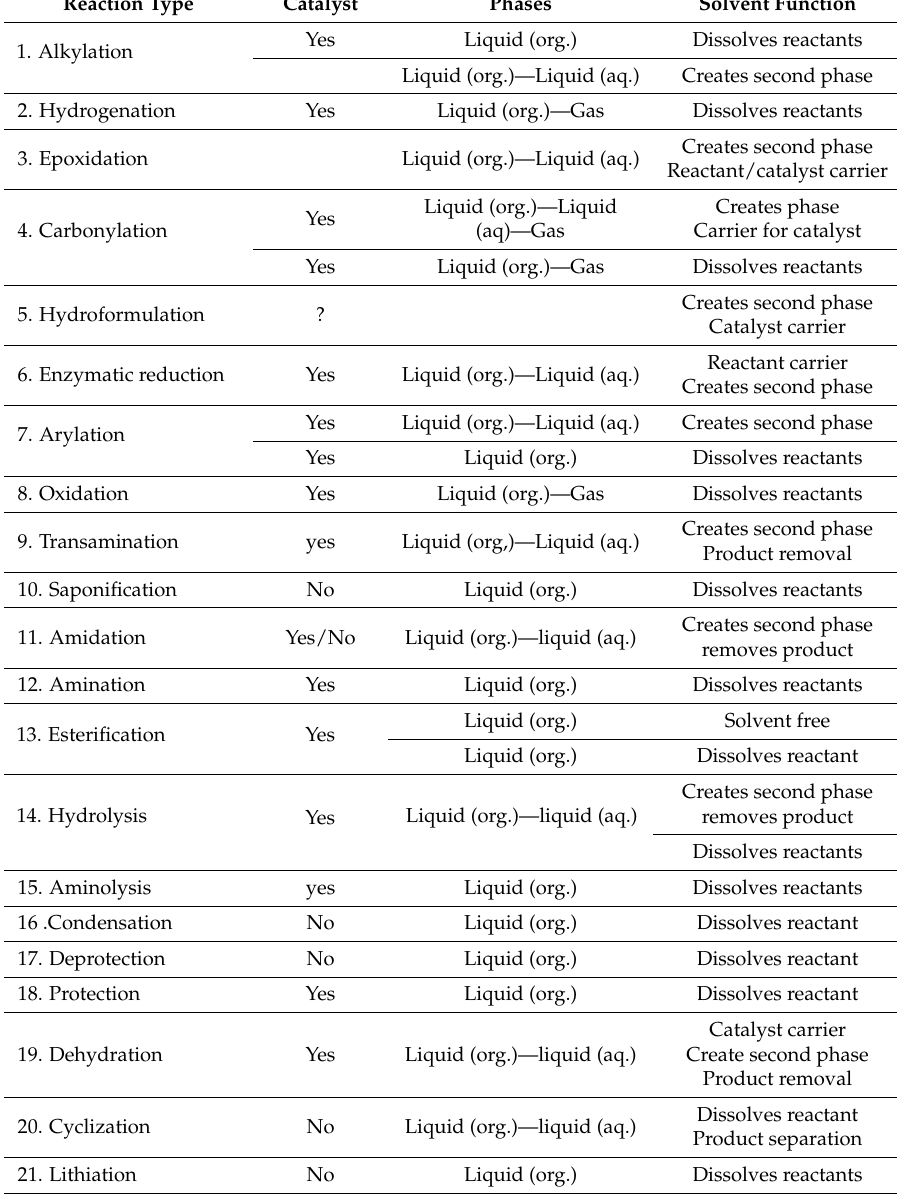
Table 6. Reaction types included in database, phases involved and function of the used